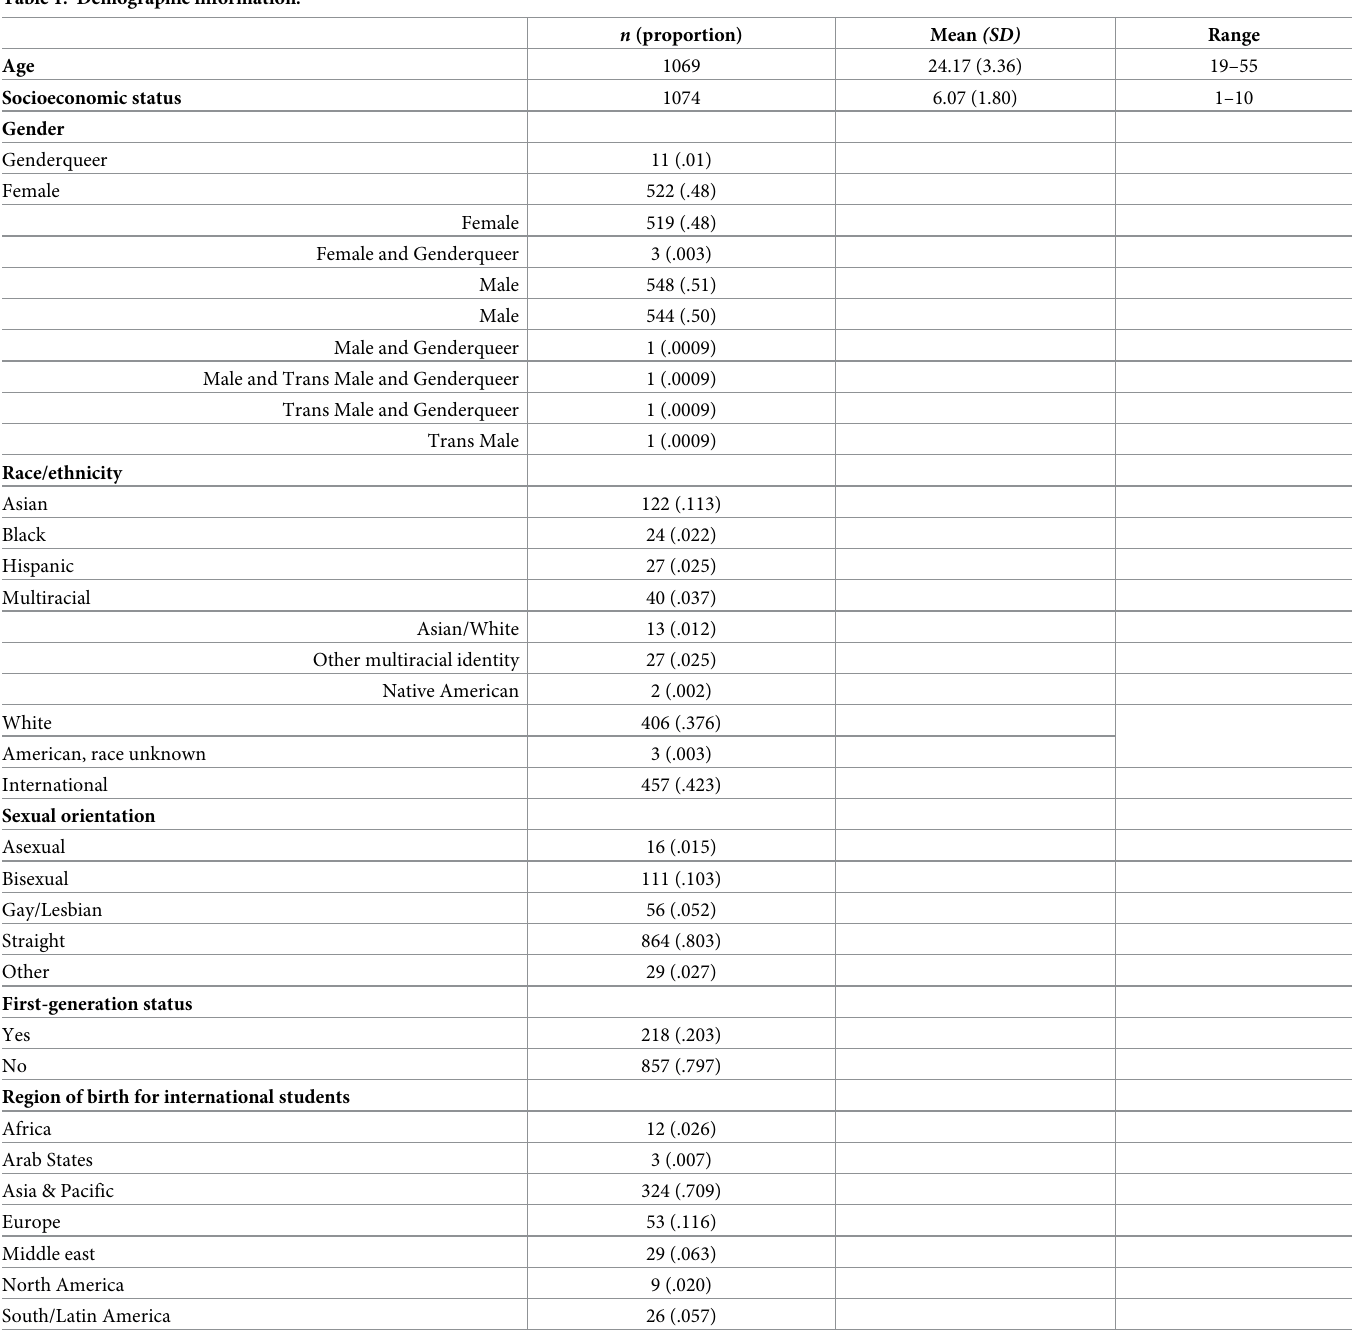
Table 1. Demographic